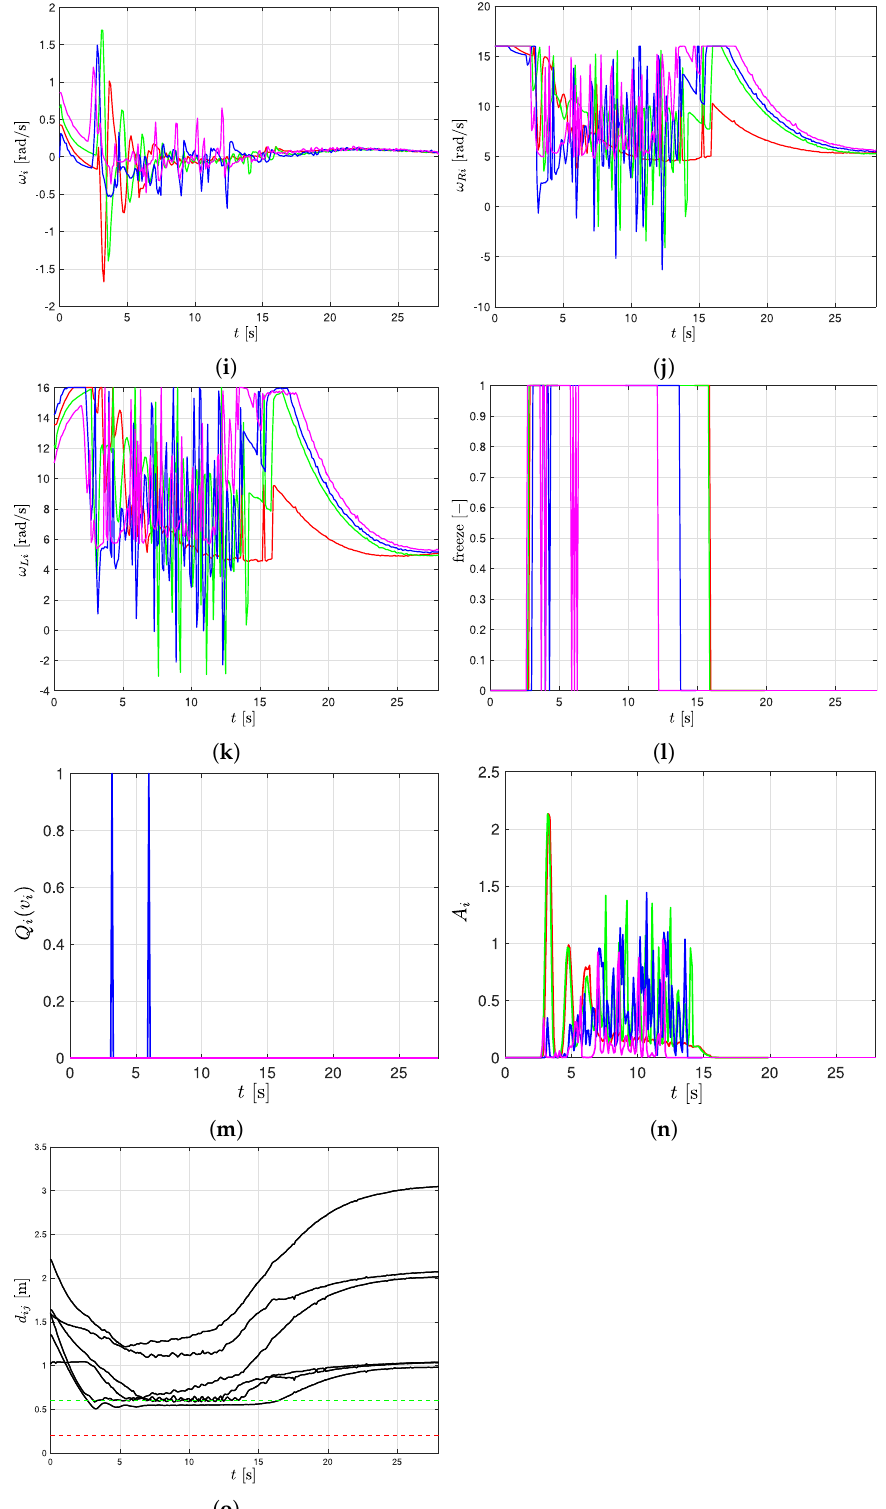
Figure 6. Experiment EX1—robots execute polynomial trajectory. ( a ) Locations of the robots on xy -plane; ( b – d ) Time plots of x, y coordinates and robot orientations respectively; ( e – g ) Position and orientation errors respectively; ( h , i ) Linear and angular velocity controls; ( j , k ) Angular velocities of the wheels; ( l ) ‘freeze’ signals; ( m ) activation of the procedure described in Assumption 4 ( n ) Collision avoidance component of the control Equation (21) ( o ) Distances between